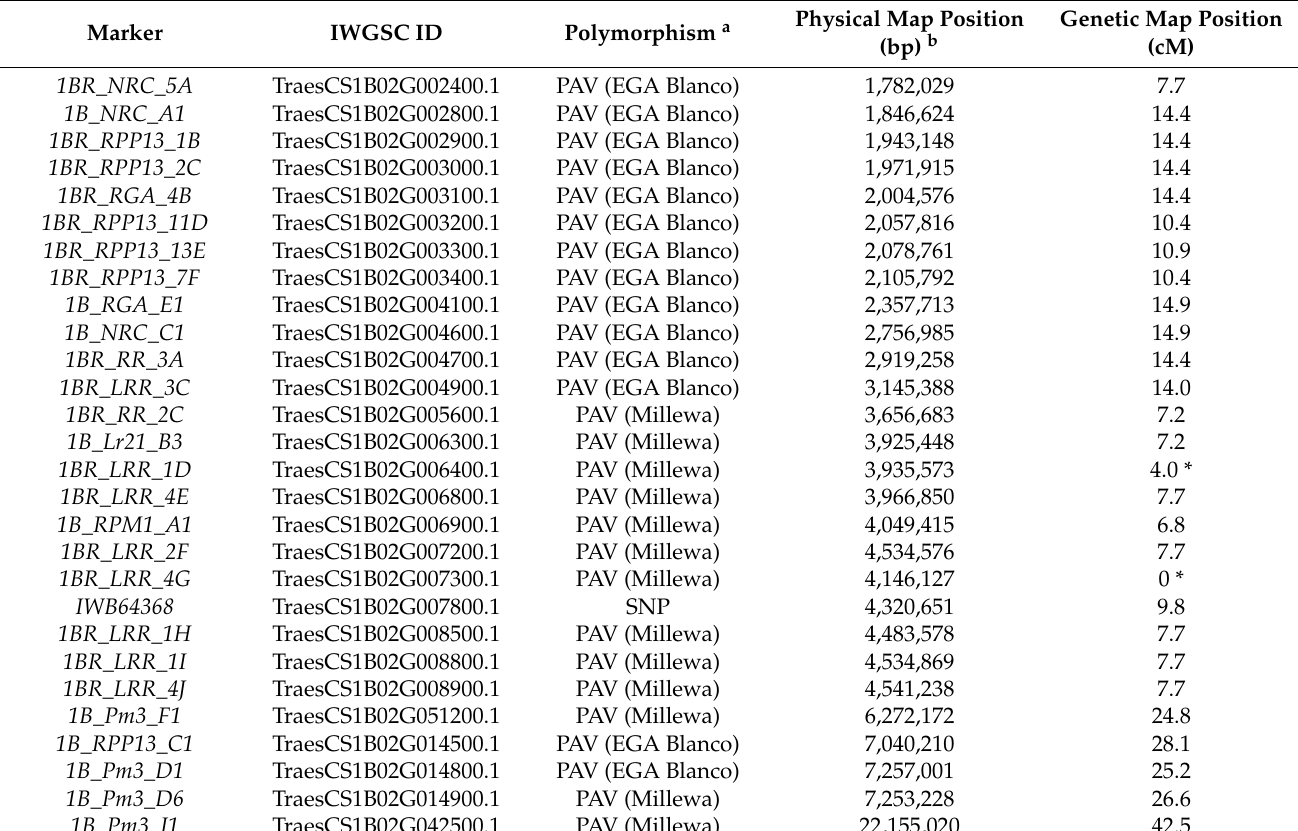
Table 1. Markers derived from annotated R -genes within the 21.5 Mbp QTL interval from the reference sequence and mapped to chromosome 1BS in the EGA Blanco/Millewa DH population. Physical position of gene annotations and the genetic map position of R -gene markers are